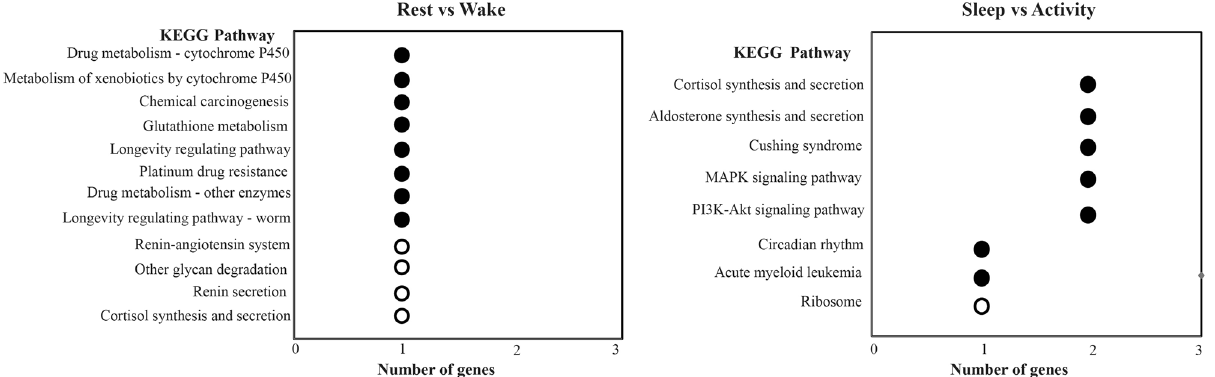
Figure 3. KEGG pathways significantly enriched for DEGs from rest vs wake and sleep vs activity comparisons. The black and white bubbles represent pathways that are significantly enriched for upregulated and downregulated genes,